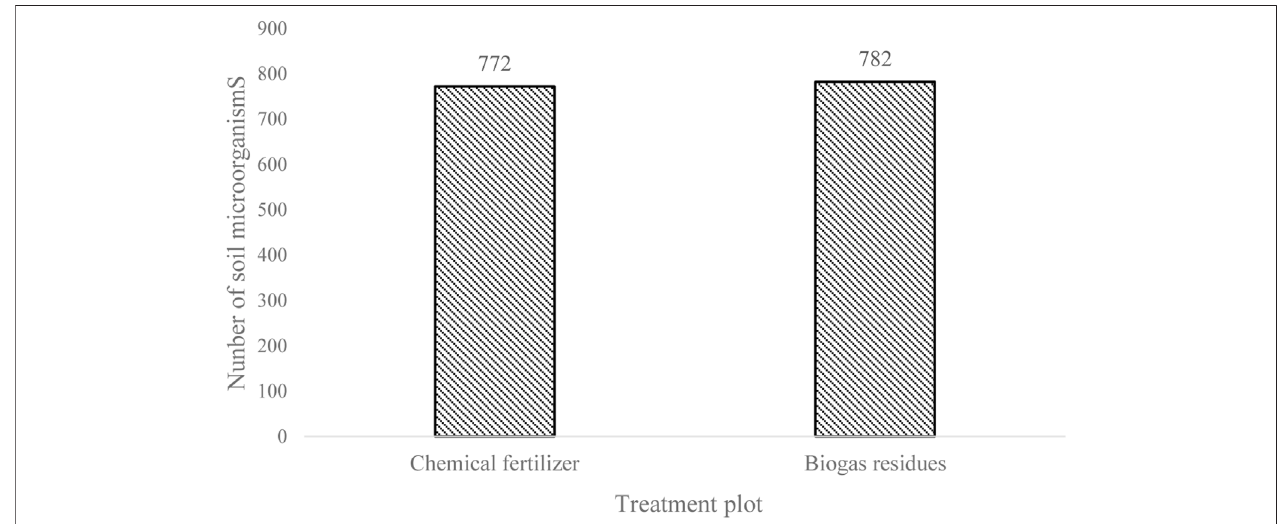
FIGURE 2 | Number of soil microorganisms in paddy soil.